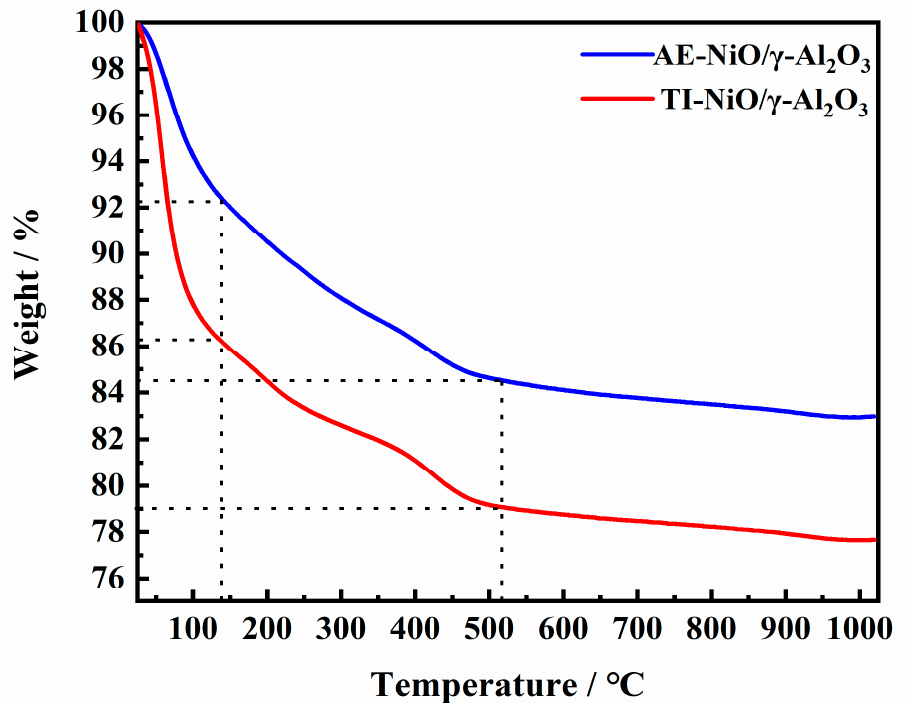
Figure 4. TG results of AE-NiO/ γ -Al 2 O 3 and TI-NiO/ γ -Al 2 O 3 . The TEM, HRTEM images and size distribution of AE-NiO/ γ -Al 2 O 3 catalyst are shown in Figure 5. The catalyst particles are highly dispersed in Figure 5b,c. As can be seen from the size distribution chart, the average particle diameter of NiO was 2.5 nm. When analyzing the exposed crystal plane, it was found that the crystal plane spacing of the exposed particles was 0.203 nm, which was consistent with the NiO (200) crystal plane, indicating that the active component is NiO. Compared with Figure 6 (TEM images of TI-NiO/ γ -Al 2 O 3 ), it is obvious that the distribution of NiO on AE-NiO/ γ -Al 2 O 3 is more uniform and the particle diameter of NiO (2.5 nm) is smaller than that of TI-NiO/ γ -Al 2 O 3 (4.5 nm). Compared with the TEM and HRTEM images of AE-NiO/ γ -Al 2 O 3 , TI-Ni/ γ - Al 2 O 3 are relatively unevenly distributed, with an average particle size of 4.5 nm. The lattice fringes are not clear, and the exposed crystal plane of NiO cannot be confirmed. X-ray Photoelectron Spectroscopy (XPS) measurements were performed to determine the existing form of the Ni on the surface of the γ -Al 2 O 3 . The binding energy of Ni 2p are shown in Figure 7. It’s observed that the binding energy of Ni in the AE-NiO/ γ -Al 2 O 3 or TI-NOi/ γ -Al 2 O 3 does not change before and after the reaction. The binding energy around 856.0 eV and 862.0 eV can be attributed to Ni 2p 3/2 and its satellite peak Ni 2p 3/2sat , respectively [35]. It has been proposed that the Ni 2p 3/2 peak with a binding energy of 856 eV and the corresponding shake-up satellite peak at 862 eV were characteristics of NiAl 2 O 4 [36]. The same conclusion was also reported by Huang et al. [37]. The energy band at 873 eV can be attributed to Ni 2p 1/2 of NiO. Furthermore, satellite peak Ni 2p 1/2sat can be observed at banding energy of 880 eV, which is due to the presence of Ni ions in NiO coming from the nickel configuration 2p 5 3d 9 4s [38]. Therefore, based on the XPS results, it can be concluded that nickel manly exists in the form of active phase NiO and a very small amount of inactive NiAl 2 O 4 on the surfaces of all prepared